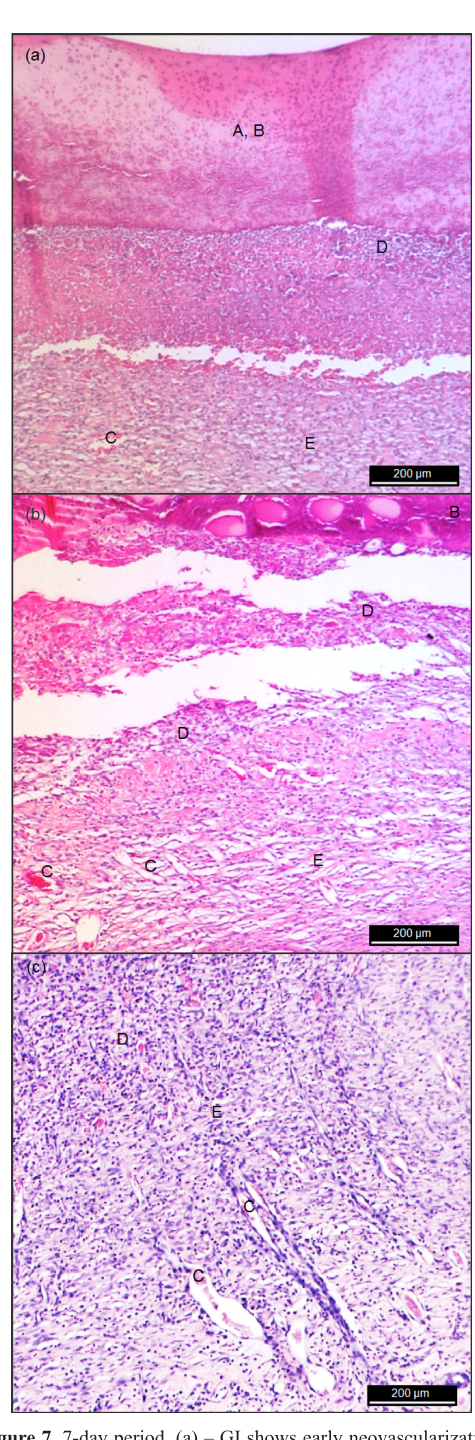
Figure 7. 7-day period, (a) – GI shows early neovascularization, crust, granulation tissue with early organization of collagen fibers and moderate inflammatory reaction in the epithelial healing process; (b) – GII shows absence of epithelium, early neovascularization, crust, moderate inflammatory reaction with early organization of collagen fibers; (c) – GIII shows absence of epithelium, early neovascularization, disorganized granulation tissue and moderate inflammatory reaction. Epithelium (A), crust (B), neovascularization (C), inflammatory infiltrate (D) and organization of collagen fibers (E). Staining: